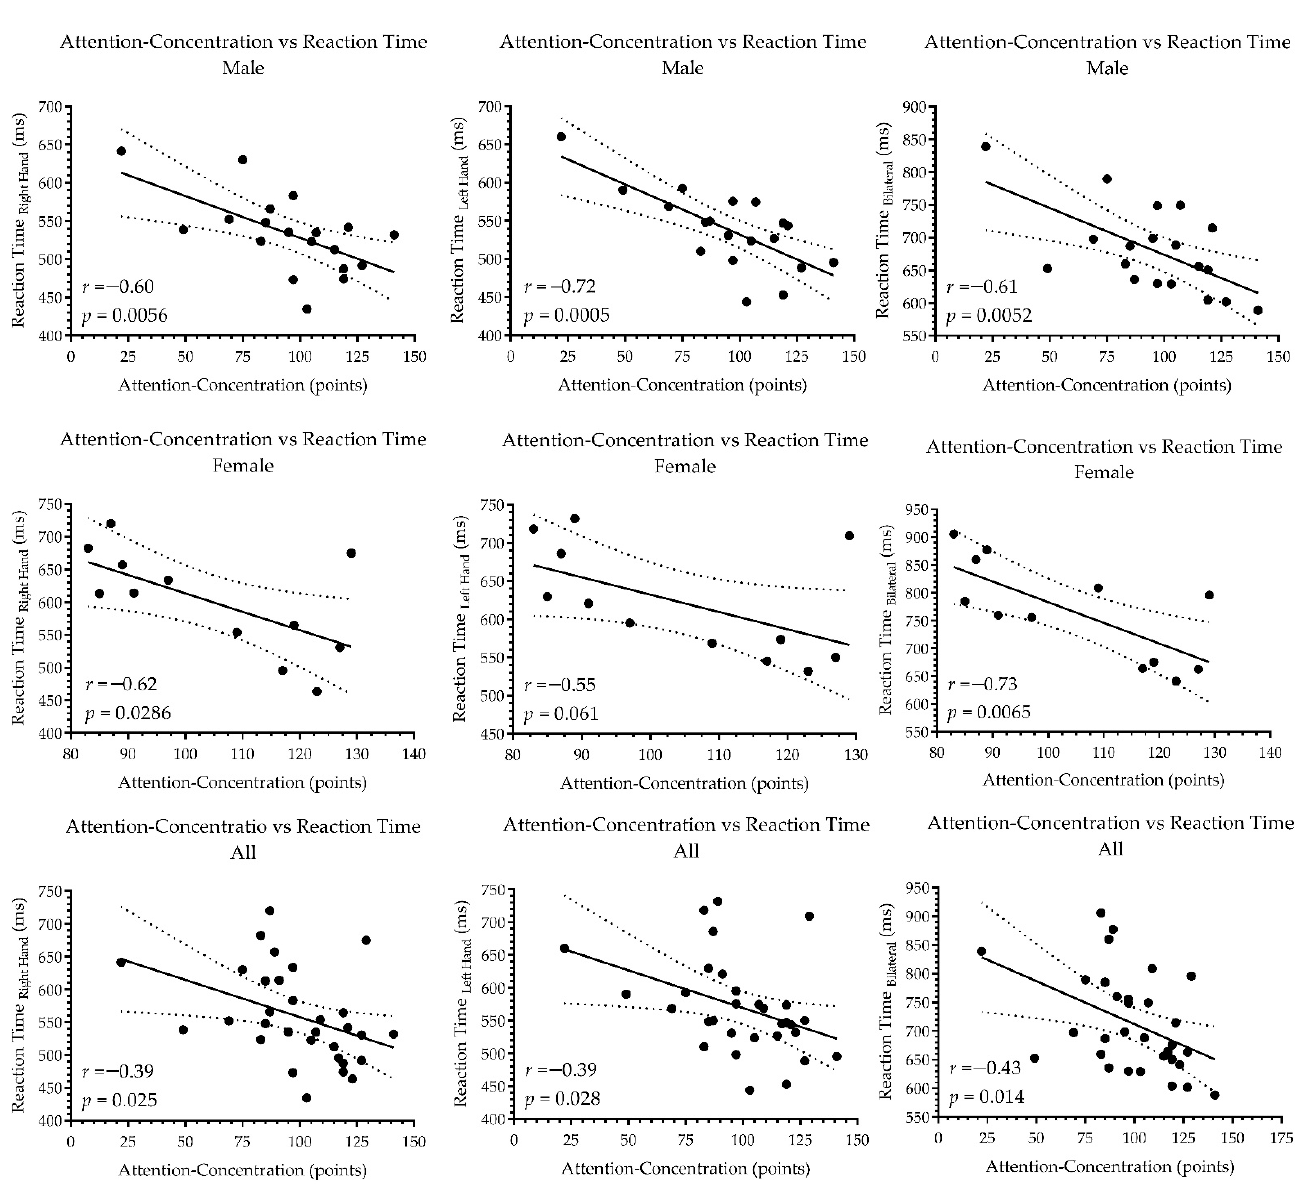
Figure 3. Correlation analysis between the capacity of attention-concentration and reaction time.